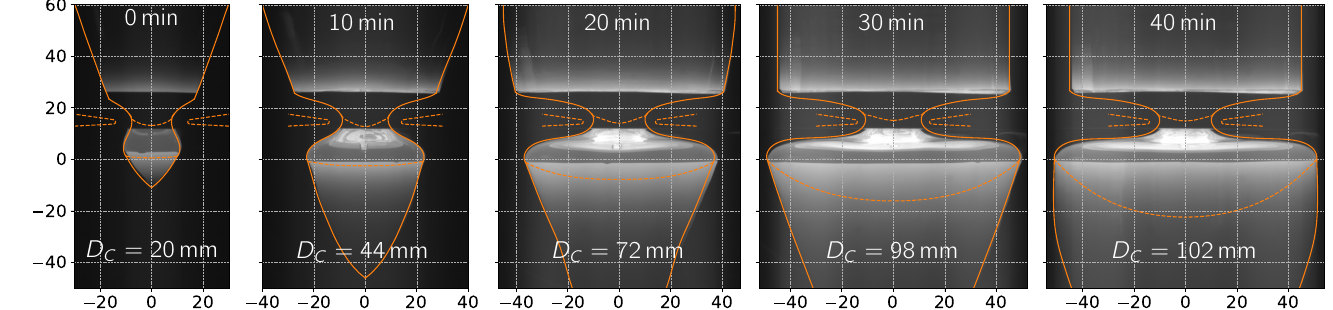
Figure 8. Comparison of the shapes of phase boundaries in the transient FZoneT simulation with experimental photos during the cone growth (0–30min) and cylindrical growth (40min)